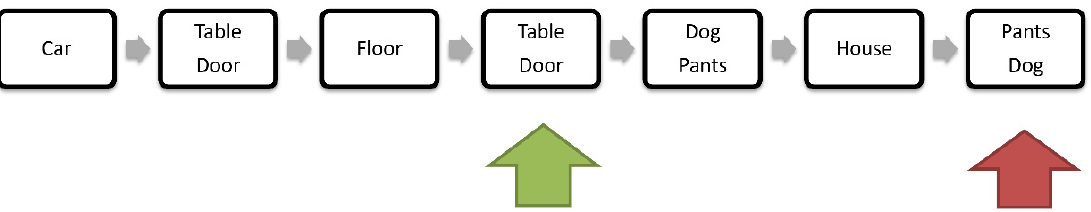
Figure 1. Executive attention (EA) task. Illustration depicts seven trials (black squares visually displaying single words or word pairs) during the modified computerized verbal n -Back task. Participants are instructed to study displayed word stimuli in order to recognize an exact stimulus that appeared two trials ago by key press response. As can be viewed in the figure, the 4th trial (marked by green arrow) in the sequence requires a key-press “GO” response for correctly recognizing the stimulus that appeared two trials ago. The 7th trial (marked by red arrow) requires a “NO-GO” response (like the other trials unmarked by arrows); thus, the participant is required to correctly reject the item as a target and to avoid responding to the stimulus during “NO-GO” trials. Each trial appears for one second (squares), as do the inter-trial intervals (gray arrows, indicating inter-stimulus intervals that display a white screen for 1 s). There were three rounds of 42 “GO” and 42 “NO-GO” randomly mixed trials, with 30 s resting periods between the WM task rounds.